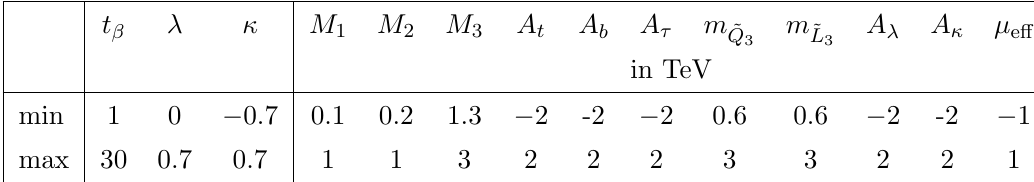
Table 3 . Input parameters for the NMSSM scan. All parameters have been varied independently between the given minimum and maximum